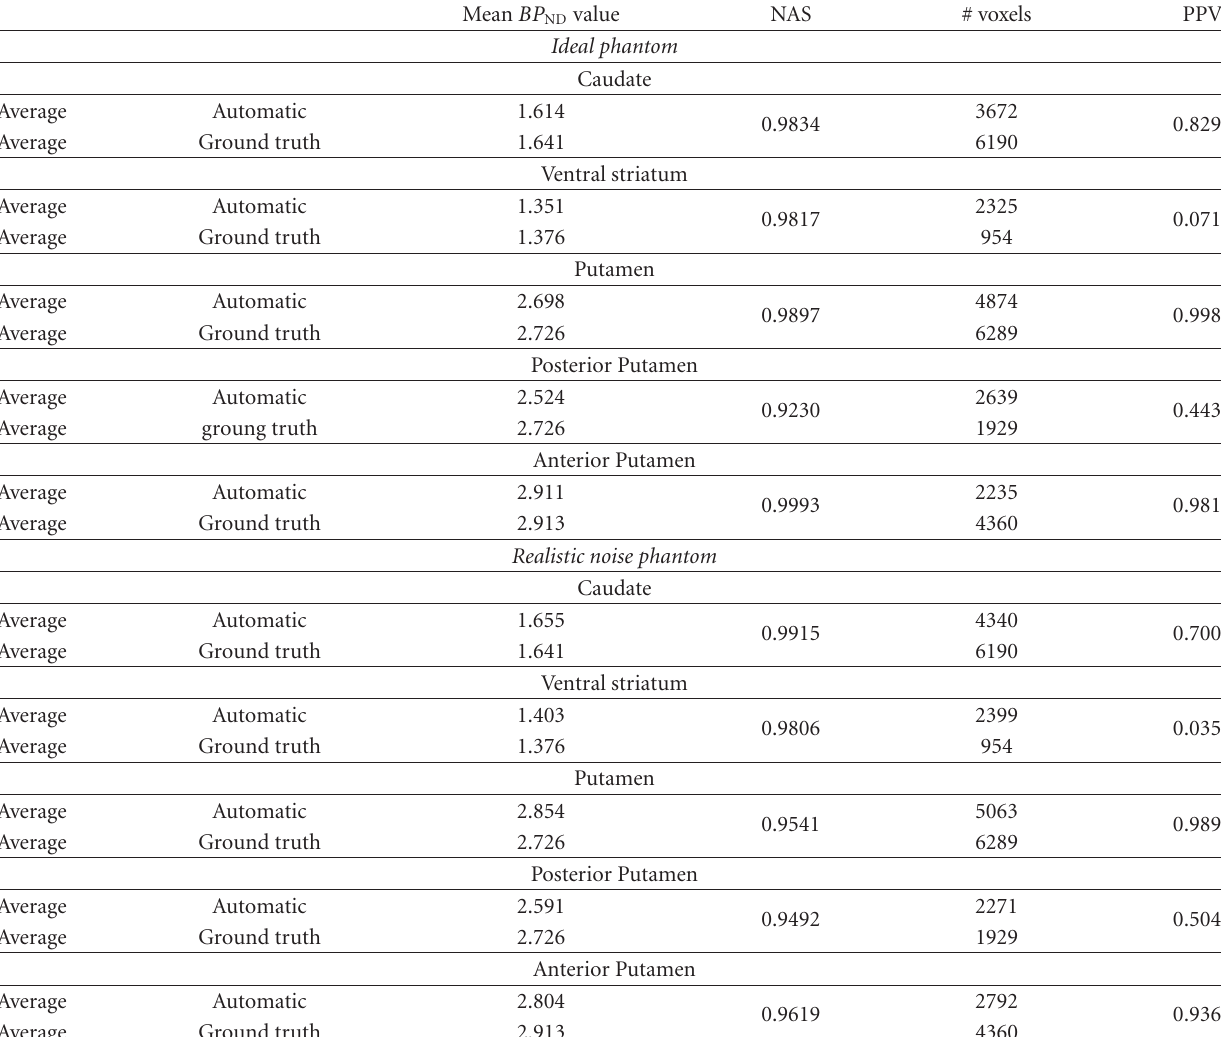
Table 1: BP ND values, NAS values, the number of voxels in each brain structure, and PPV values computed based on the ideal phantom and the realistic noise